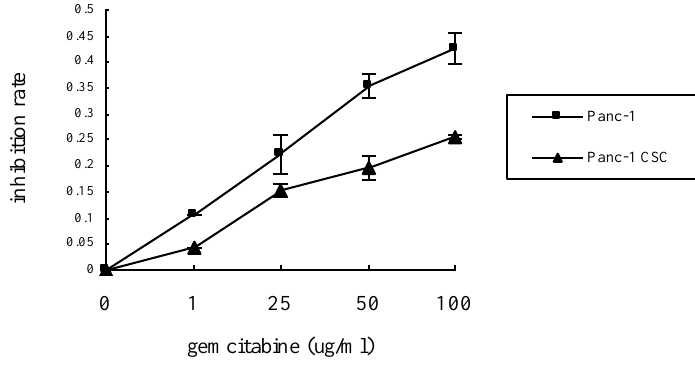
Figure 2. Panc-1 CSCs have increased chemoresistance to gemcitabine. Panc-1 CSCs or Panc-1 cells were treated with various dosages of gemcitabine for 48 h. Cell viability was determined by MTT assay. Panc-1 CSCs showed increased resistance to gemcitabine compared to Panc-1 cells cultured in